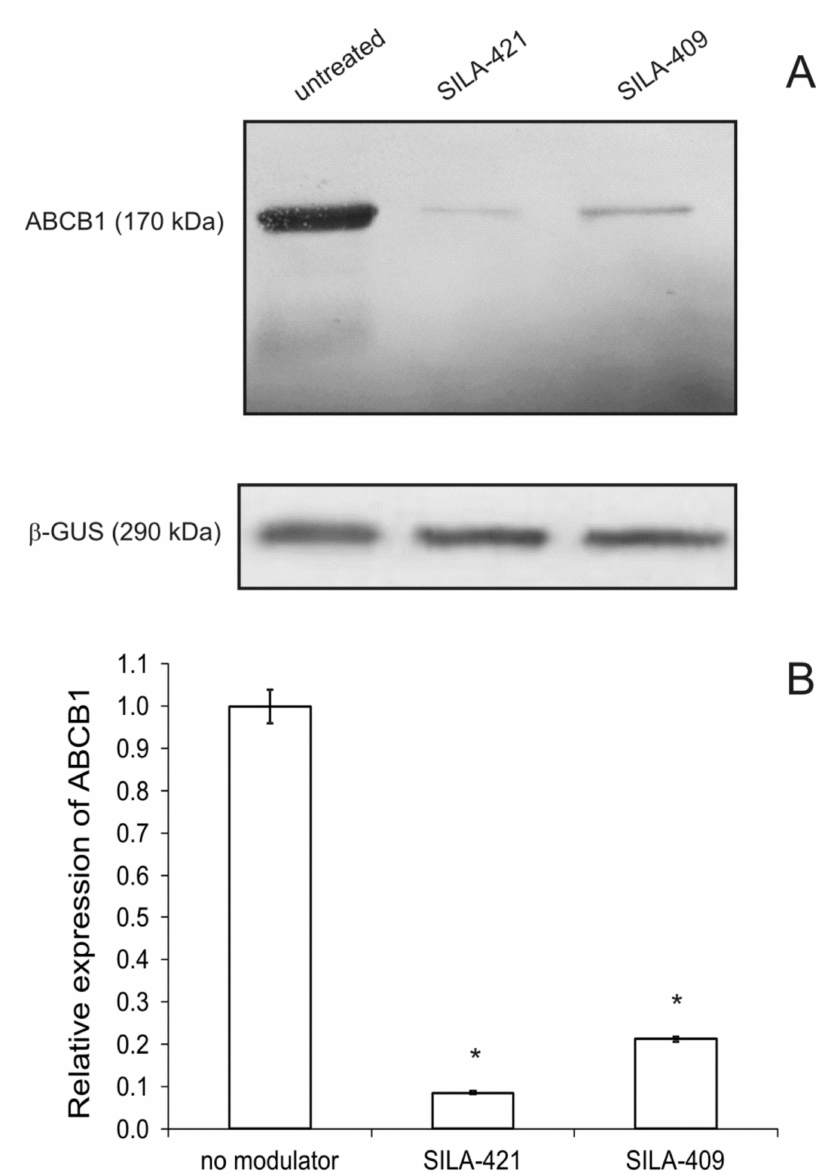
Figure 6. Western blot analysis of ATP-binding cassette B1 (ABCB1) protein level ( A ) in LoVo / Dx cells cultured with 0.5 µ M SILA-409 and SILA-421 for 48 h. The molecular masses of the proteins are indicated on the left side of the gel. β -Glucuronidase ( β -GUS) was used as a reference protein. The relative level of ABCB1 expression ( B ) was normalized to the control derived from non-treated LoVo / Dx cells. The results of three experiments ± SD are presented. The statistically significant di ff erences from the untreated controls were determined using Student’s t -test (* p <